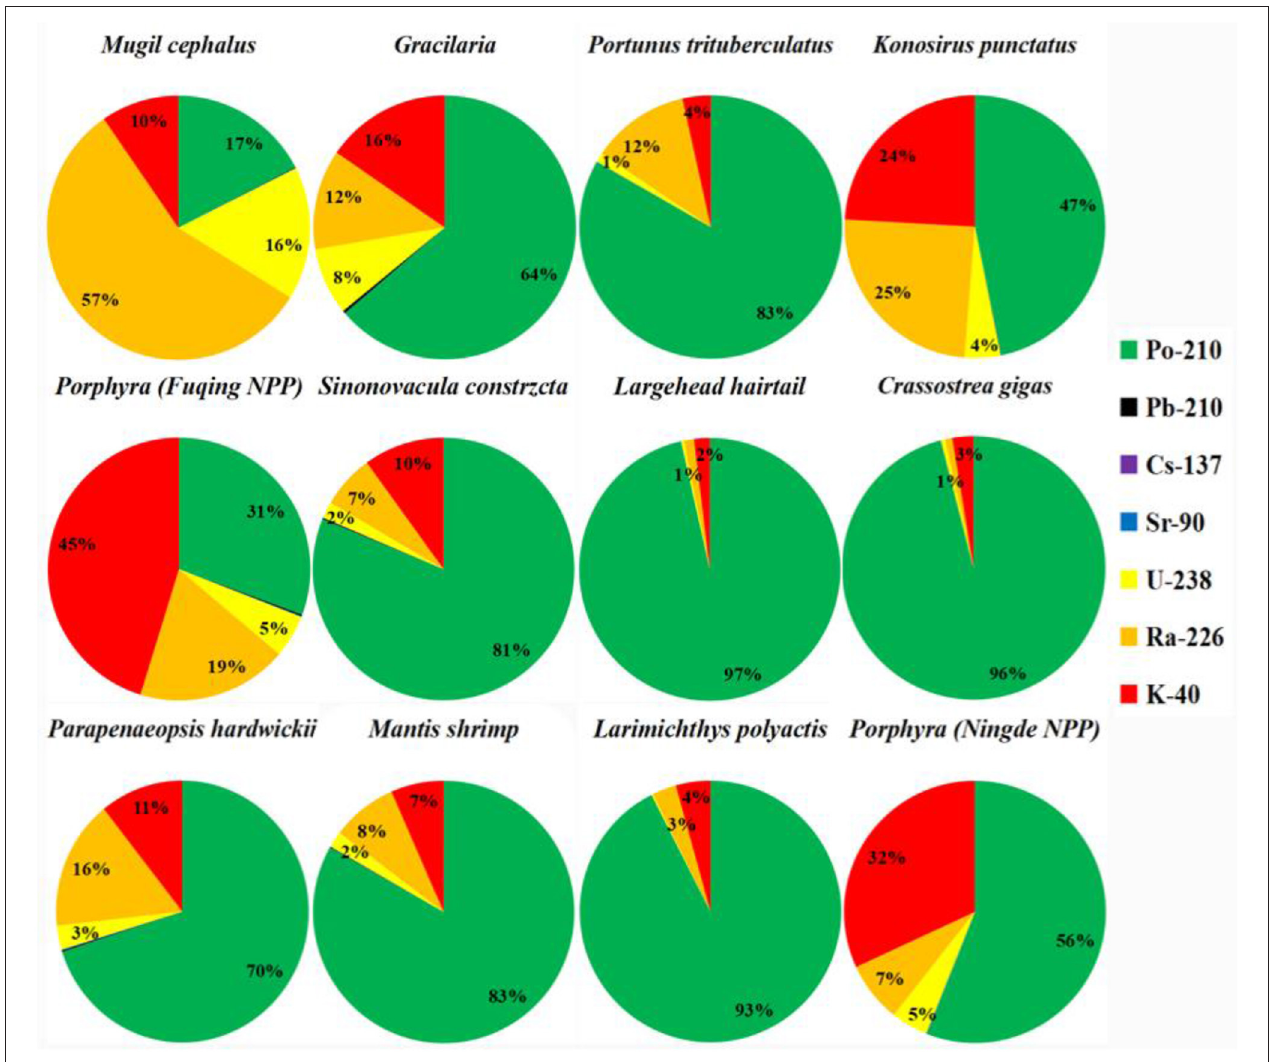
FIGURE 3 | Dose contributions of each radionuclide for the different marine organisms sampled in this